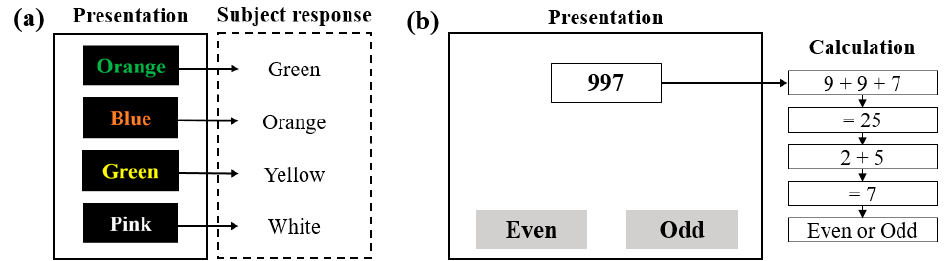
Figure 3. The methods for inducing stress: ( a ) the Stroop color word test, and ( b ) an illustration of the mental arithmetic test.